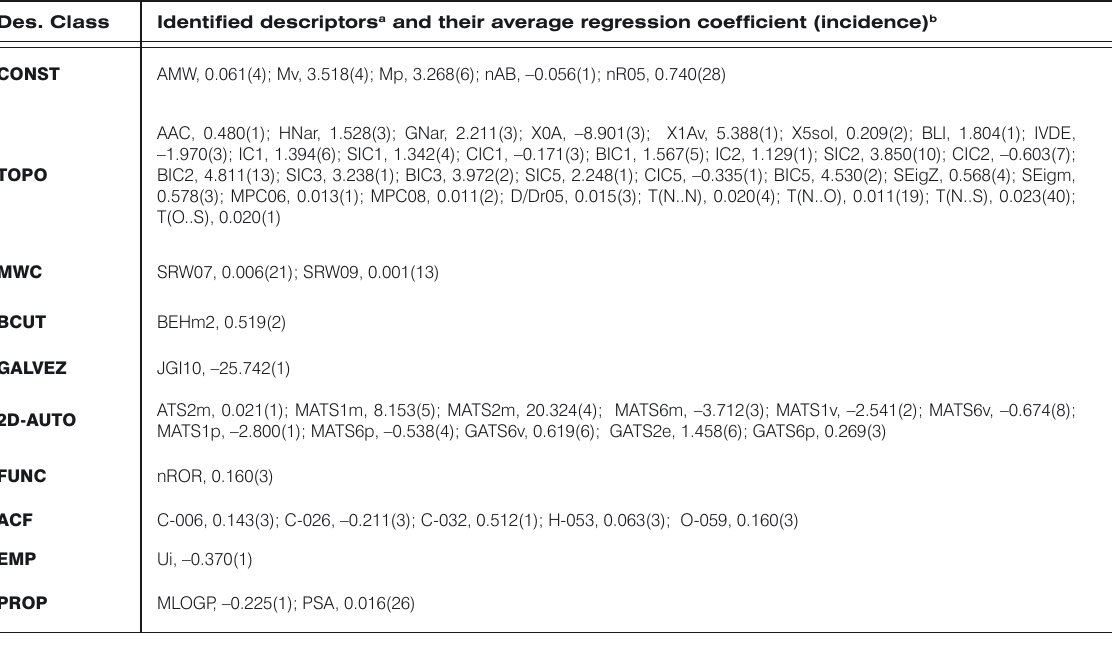
a The descriptors are identified from the three parameter models, emerged from CP-MLR protocol with filter-1 as 0.3, filter-2 as 2.0, filter-3 as 0.886, and filter-4 as 0.3 ≤ Q 2 ≤ 1.0 with a total number of 32 compounds. CONST: AMW, average molecular weight; Mv and Mp, mean atomic van der Waals volume and polarizability (scaled on carbon atom); nAB and nR05, number of aromatic bonds 5-membered rings respectively; TOPO: AAC, mean information index on atomic composition; HNar and GNar, the Narumi harmonic and geometric topological indices; X0A, average connectivity index chi-0; X1Av, average valence connectivity index chi-1; X5sol, salvation connectivity index chi-5; BLI, Kier benzene-likeliness index; IVDE, mean information content vertex degree equality; IC1 and IC2, information content indices of 1- and 2-order neighborhood symmetry; SICk, BICk and CICk, structural, bond and complementary information contents of neighborhood symmetry of k-order; SEigZ and SEigm, the eigenvalue sum from Z and mass weighted distance matrix; MPC06 and MPC08; molecular path count of 6-and 8-order; D/Dr05, distance/detour ring index of order 5; T(A..B), sum of topological distances between A..B; MWC: SRW07 and SRW09, self-returning walk count of 7- and 9-order; BCUT: BEHm2, highest eigen value n.2 of Burden matrix weighted by atomic masses; GALVEZ: JGI10, mean topological charge index of 10-order; 2D-AUTO: ATSkw, MATSkw and GATSkw, the Broto-Moreau, Moran and Geary auto-correlations of lag k, weighted by some physical property w such as atomic van der Waals volume (v), atomic polarizability (p), atomic mass (m) etc.; FUNC: nROR number of ethers (aliphatic); C-006, CH2RX; C-026, R-CX-R; C-032, X-CX-X; H-053, H attached to C0(sp3) with 2X attached to next C; O-059, Al-O-Al; EMP: Ui, unsaturation index; PROP: MLOGP, Moriguchi octanol-water partition coefficient (logP); PSA, fragment-based polar surface area. b See footnote under Table